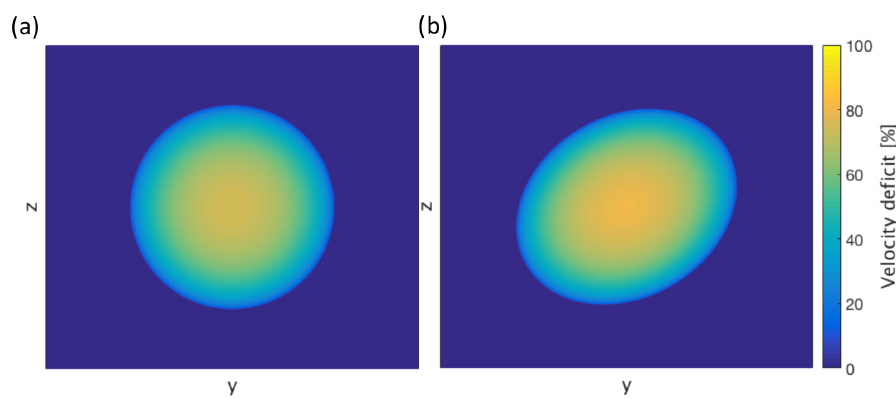
Figure 12. Qualitative cross-stream slices of stream-wise velocity deficit. The perspective is looking downwind. (a) A graphic representation of the classical Gaussian shape of the magnitude of wake velocity deficit. (b) An ellipsoid which represents the vertical stretching of the 3-D structure of a turbine wake as a consequence of wind veer.